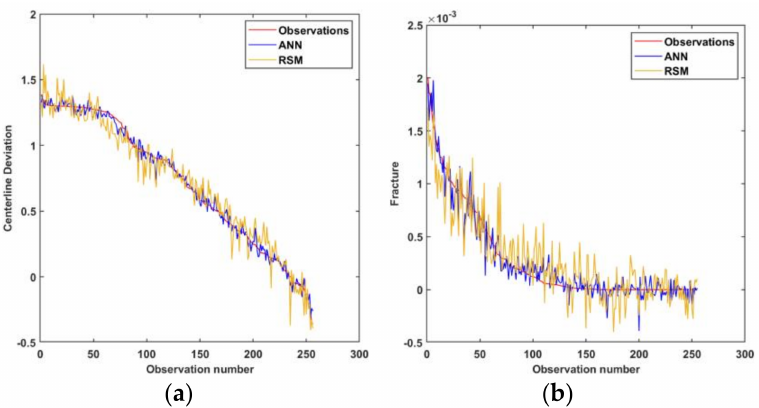
Figure 15. Model values for observations: ( a ) centerline deviation, ( b ) fracture objectives.